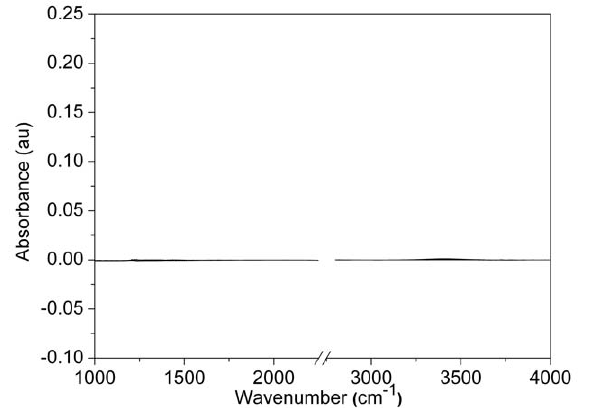
Figure 3. FTIR spectromicroscopy difference spectra of Rat-1 Fibroblasts in lag phase. FTIR spectra from a cluster of lag phase Rat- 1 cells grown on a CaF 2 optical slide. Spectra were recorded (25 6 25 m m 2 aperture) over 160 minutes after washing the cells with DMEM prepared with 100% 2 H 2 O The initial spectrum (defined as t =0) was used as the reference. The scale is the same as that used in Figure 2 A . The horizontal line indicates that there is essentially no difference between the various spectra.